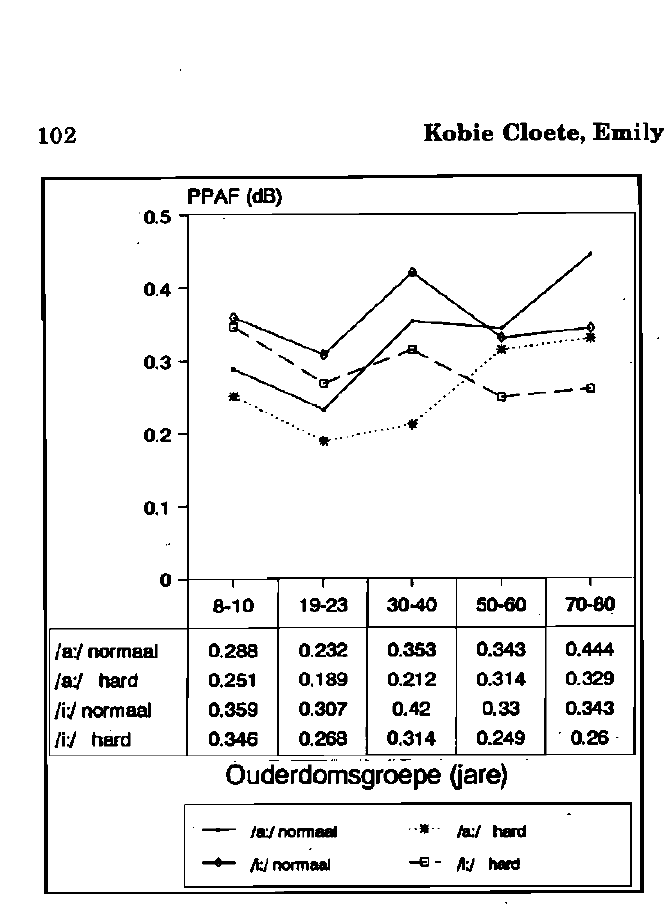
Figuur 4: PPAF-waardes van mans en dames in verskillende ouderdomsgroepe tydens produksie van l&'J en /is/ met normale en verhoogde luidheid. van mekaar nie. Lae PPAF-waardes reflekteer 'n hoe mate van reelmaat in stembandvibrasie. Die groep 19- 23 jaar behaal vir beide vokale /a:/ en Iv.l die laagste PPAF-waardes wat dui op die mees reelmatige stem- bandvibrasie van al die ouderdomsgroepe. Hierdie